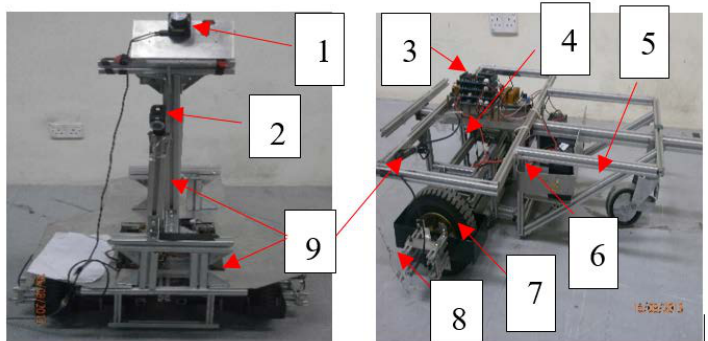
Figure 10. Developed wheeled mobile robot (WMR) platform in this research: (1) LRF, (2) Wi-Fi camera,